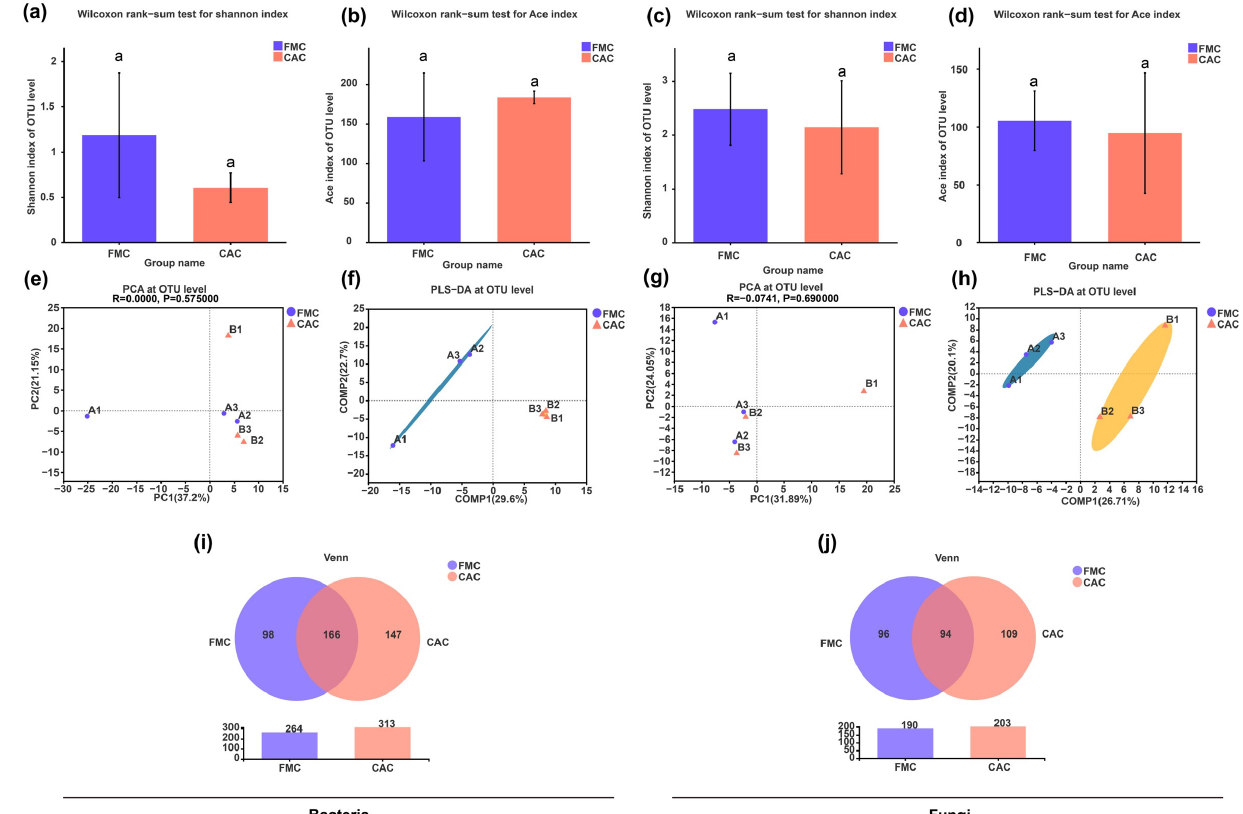
Figure 1. Comparison of endophytic microbiota structures in stems of sugarcane at a similarity level of 97% between FMC and CAC treatments (OTU level). ( a ) The Shannon index indicates endophytic bacterial diversity. ( b ) The Ace index indicates endophytic bacterial richness. ( c ) The Shannon index indicates endophytic fungal diversity. ( d ) The Ace index indicates endophytic fungal richness. ( e ) PCA of endophytic bacteria communities. ( f ) PLS-DA score plot of endophytic bacteria